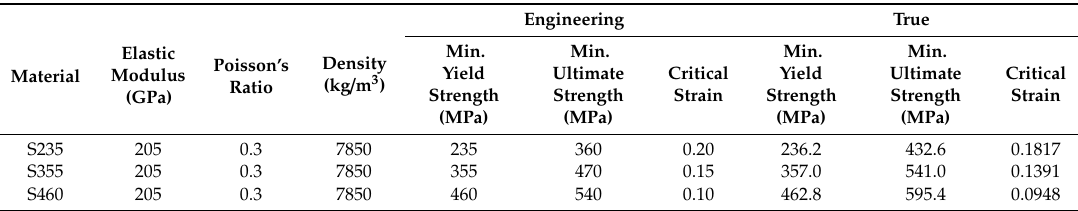
Table 6. Summarization of material